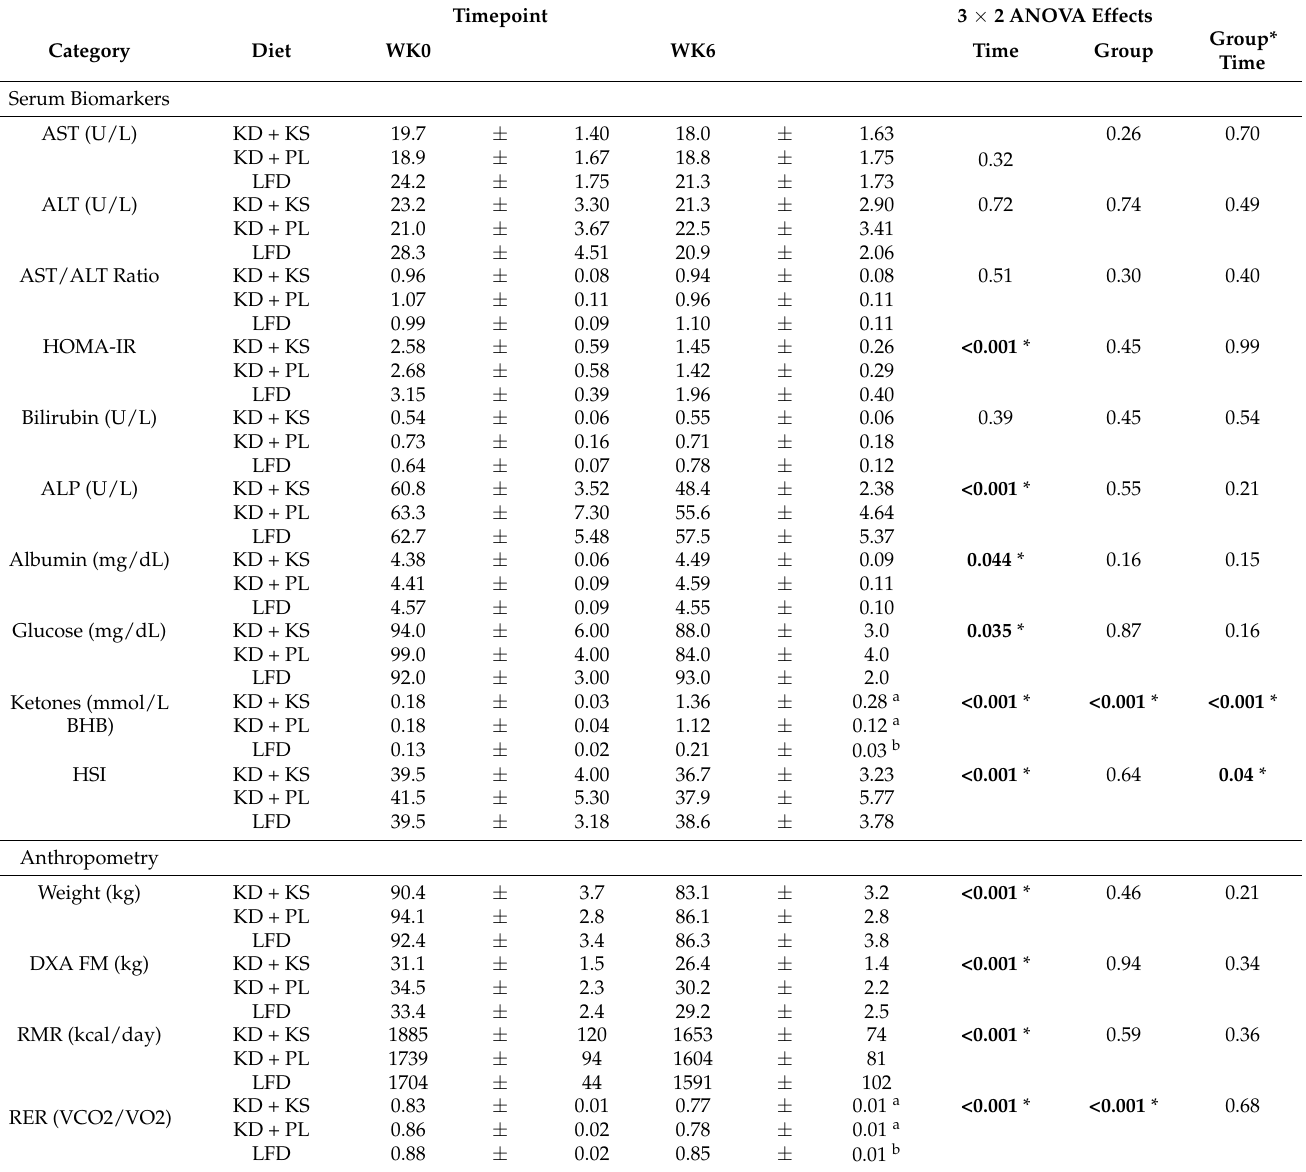
Table 3. Serum biomarkers and anthropometric